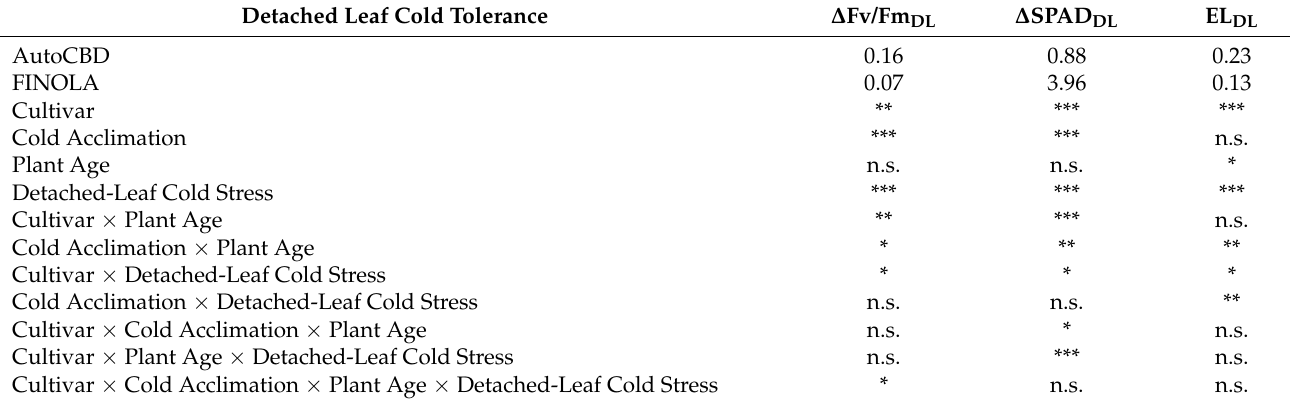
Table 3. Summary of effects of cultivar, cold acclimation, plant age, detached-leaf cold stress, and their interactions and mean values for plant health values of ‘AutoCBD’ and ‘FINOLA’. Cold tolerance was quantified with ∆ Fv/Fm DL (difference between Fv/Fm taken prior to whole-plant cold stress and after detached-leaf cold stress), ∆ SPAD DL (difference in mean SPAD values taken prior to whole- plant cold stress and after detached-leaf cold stress), and EL (ratio between EC of leaf sample after detached-leaf cold stress and EC of leaf sample after cell